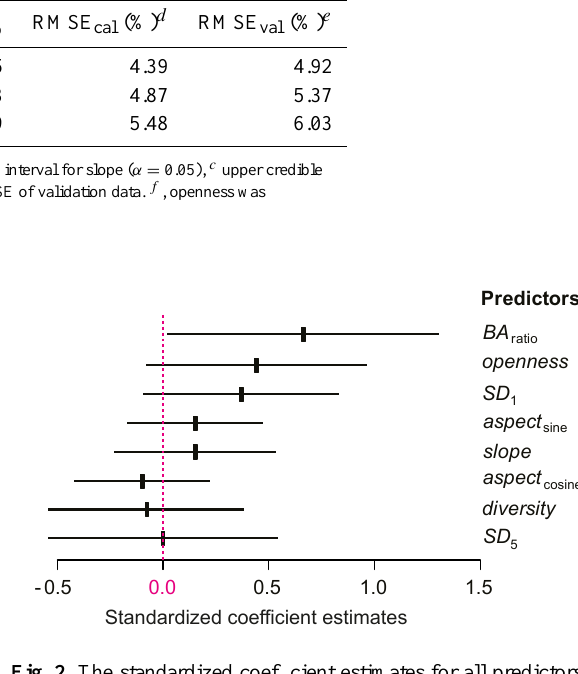
Table 3. Simple linear regression results.